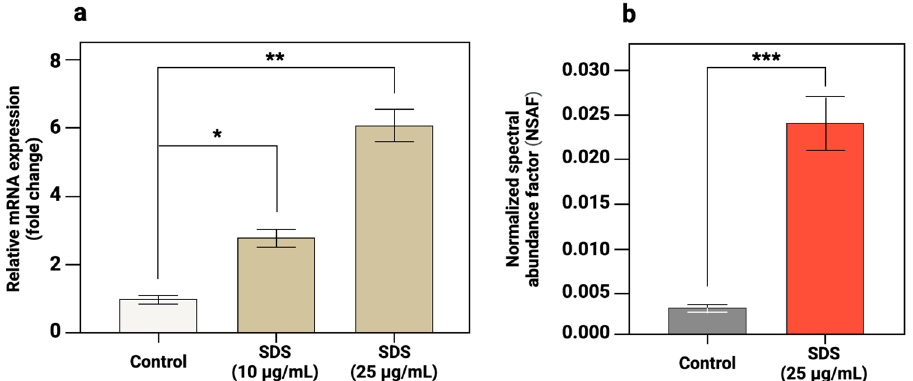
Figure 6. The mRNA expression levels of MCM6 and corresponding MCM6 proteomic profiles in control and SDS-exposed HaCaT cells. Histograms show ( a ) the fold change in MCM6 expression in SDS-exposed cells compared to control cells; ( b ) protein abundance of MCM6 assessed via LC–MS/MS analysis. The significant upregulations are marked with asterisks (* P = 3.8e−5; ** P = 2.8e−5; *** P = 3.0e−4; at alpha level 0.05). Error bars represent the standard deviation between technical